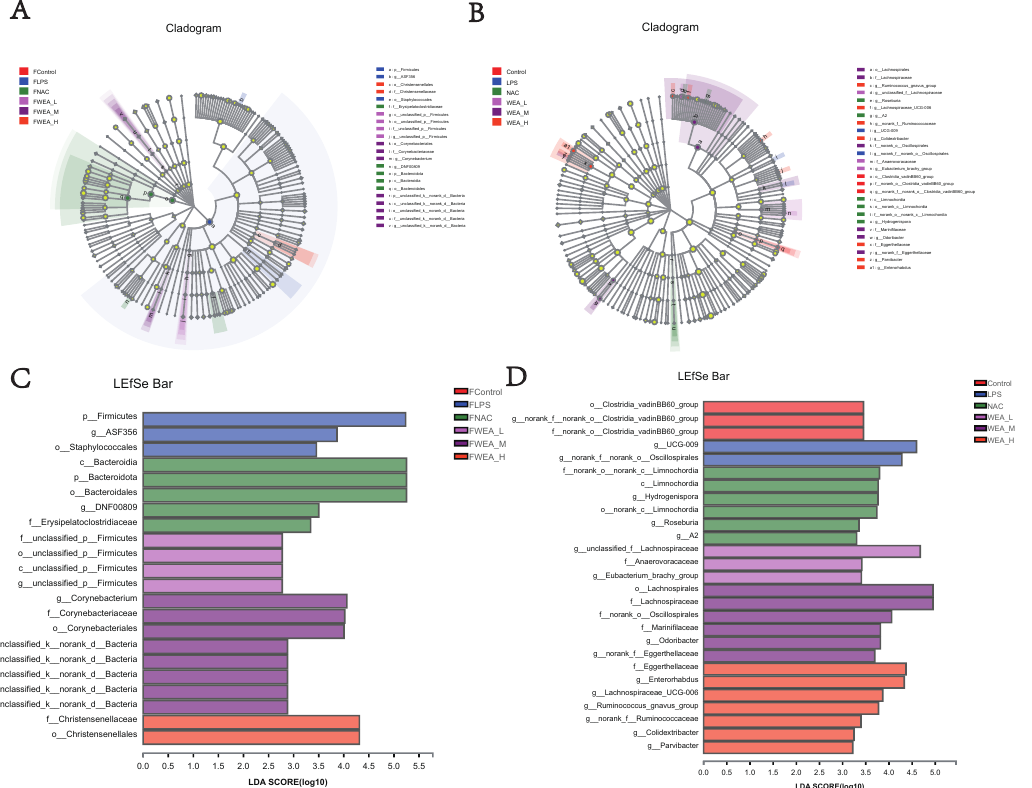
Figure 9. LEfSe analysis of the gut microbiota. Linear discriminant analysis of the gut microbiota in the ( A , C ) feces and the ( B , D ) intestinal digesta. ( A , B ) Evolutionary branch diagram. ( C , D ) LDA value distribution histogram, listing taxa meeting the LDA score threshold > 2. FLPS = 10 mg/kg lipopolysaccharide; FNAC = 300 mg/kg N-acetylcysteine; FWEA_L = 50 mg/kg water extract of A. grossedentata; FWEA_M = 100 mg/kg water extract of A. grossedentata; FWEA_H = 200 mg/kg